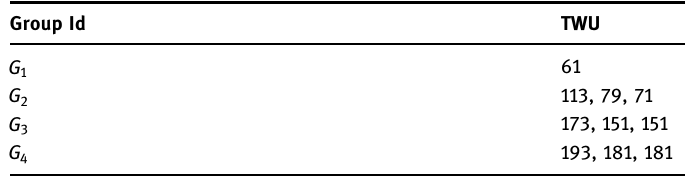
Table 7: TWU - grouping based on descending order for items in database 1 Group